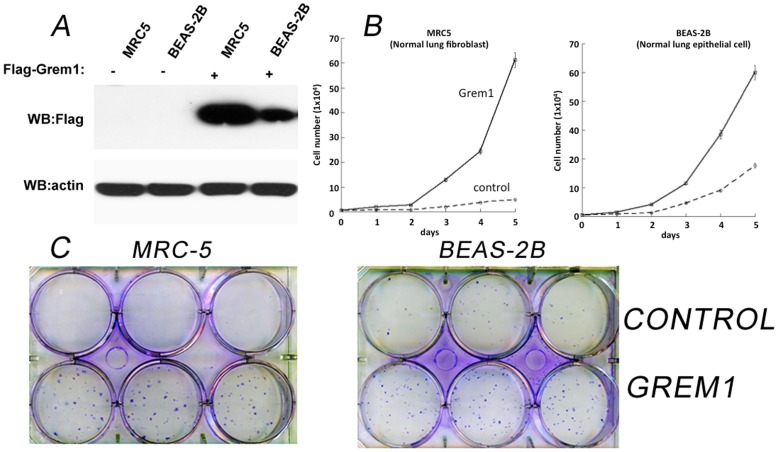
Effect of Grem1 overexpression on MRC5 and BEAS-2B cell proliferation.MRC5 and BEAS-2B pBabepur-flag-Grem1 cells overexpressing flag-tagged Grem1. (A) Grem1 protein expression by immunoblot analysis. B-actin protein expression was the loading control. (B) Growth curve of MRC5 and BEAS-2B cells infected with control vectors or flag-tagged Grem1. Cells (5×103 cells/well) were seeded onto 6-well plates. For each day, three plates were counted and averaged. Error bars show standard deviation of triplicate samples. (two-tailed, unpaired t-test between GREM1 and vector MRC5 p = 9.88×10−5 BEAS-2B p = 9.04×10−5) (C) Colony formation assays documenting the effect of Grem1 overexpression on the growth of MRC5 and BEAS-2B cells.